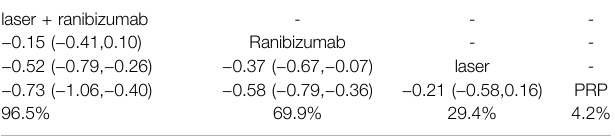
TABLE 2 | Network meta-analysis of central retinal